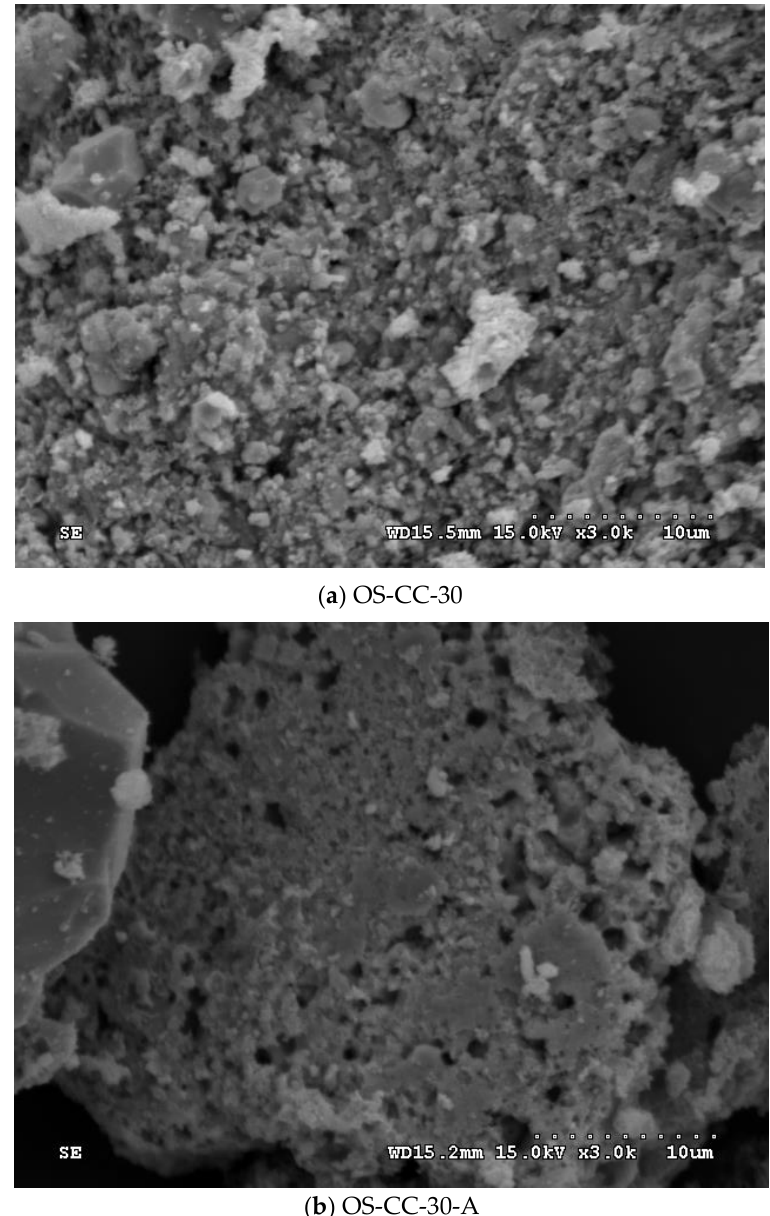
Figure 4. Images of SEM (×3000) for the CC products of ( a ) OS-CC-30 and ( b ) OS-CC-30-A.